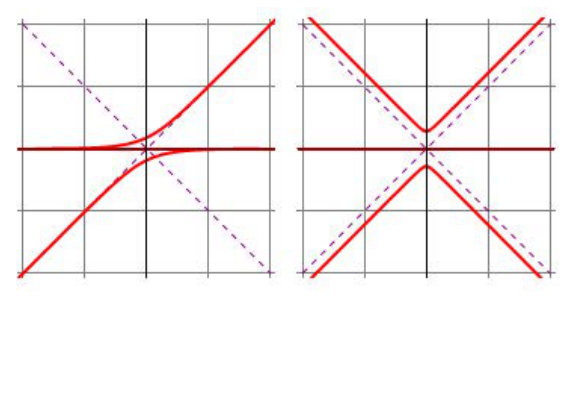
Fig. 7. Timelike elastic curves with K( y ) = y 2 ± 1